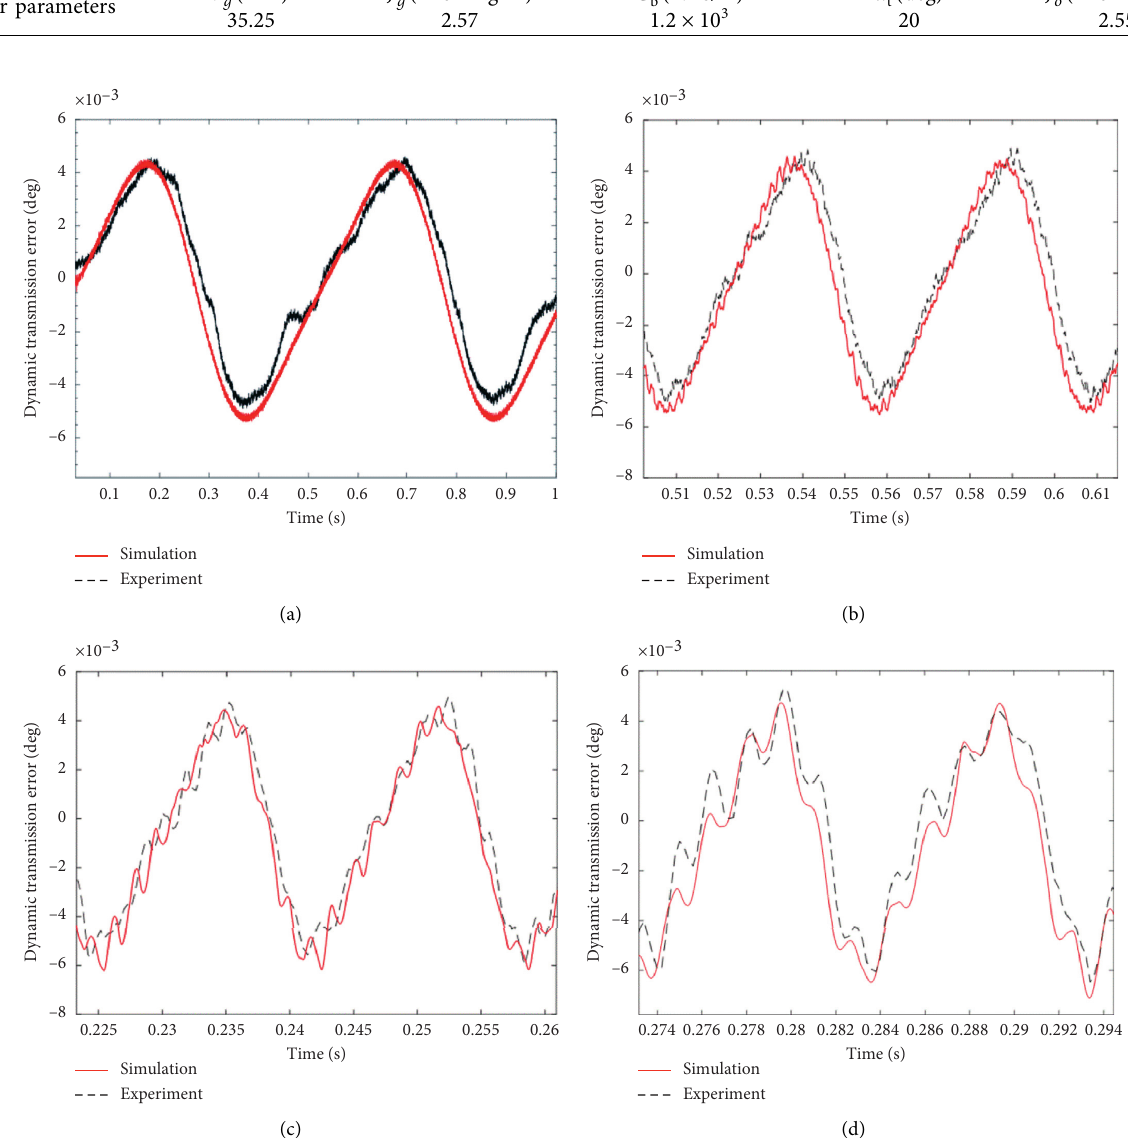
Figure 10: Comparison between simulations and experiments of dynamic transmission error. (a) 60rpm. (b) 600rpm. (c) 1800rpm. (d)